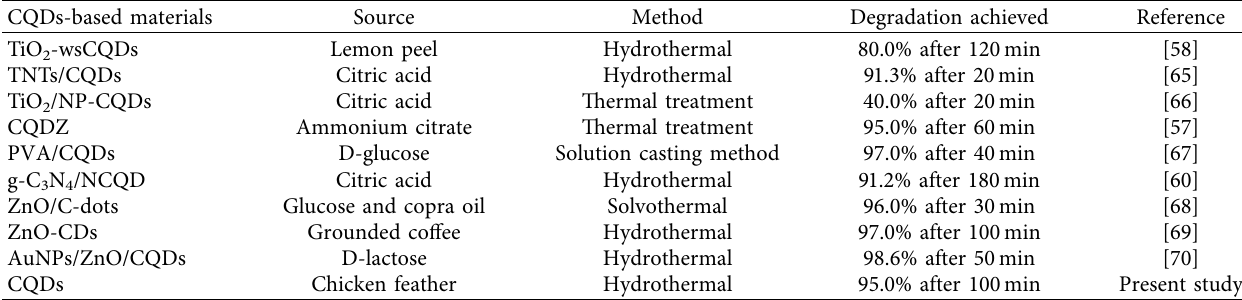
Figure 9: XRD pattern before and after the photocatalytic performance of CQDs. Table 1: CQDs-based materials’ synthesis and photocatalytic degradation of